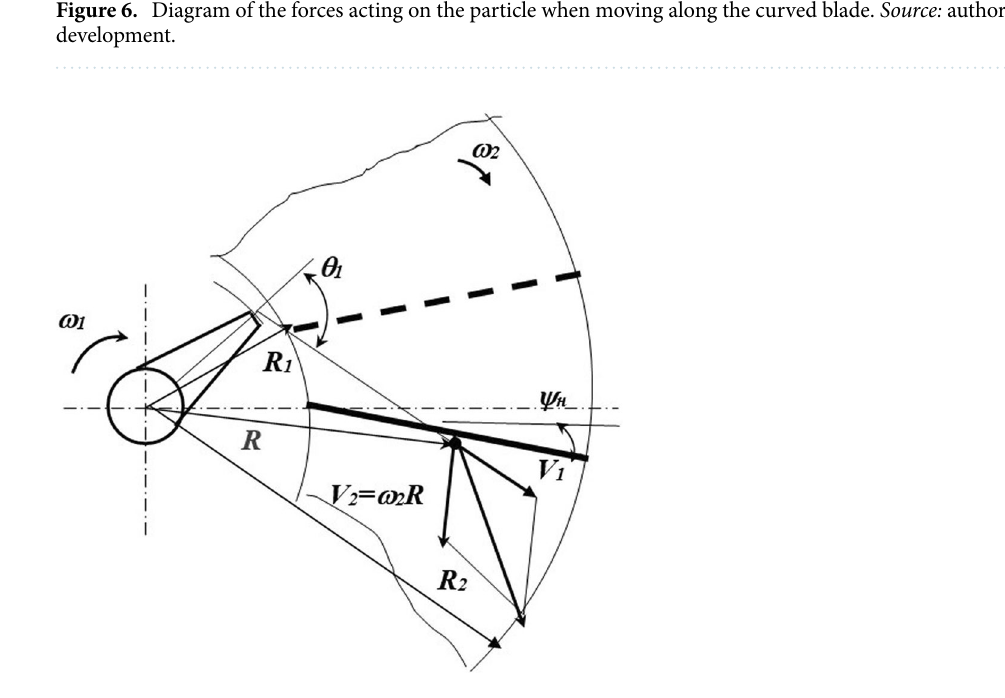
Figure 7. Diagram of the interaction of seeds with the blades of a centrifugal disk. Source: author’s